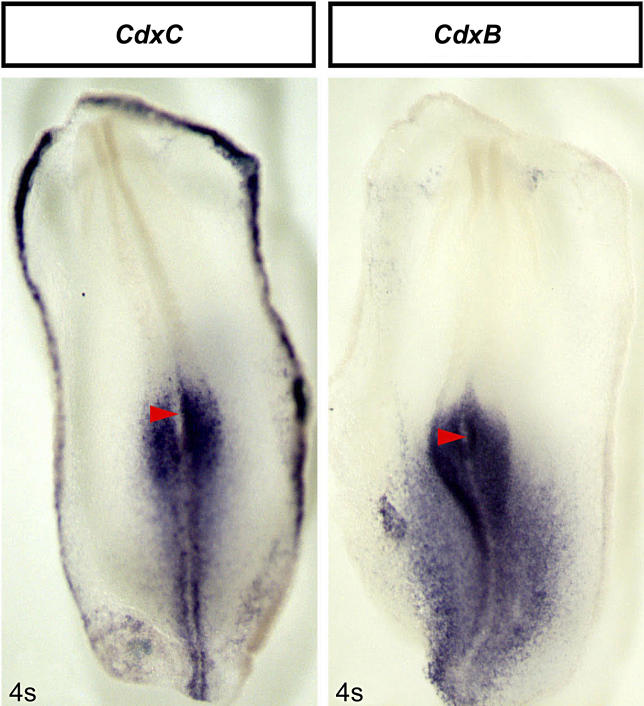
Expression Pattern of
CdxB and
CdxC
Whole mount in situ hybridization of
CdxC and
CdxB in HH stage 8 embryos (4-somite). Expression of
CdxC and
CdxB is limited to levels adjacent and caudal to the node. The node is indicated by the red arrowhead.